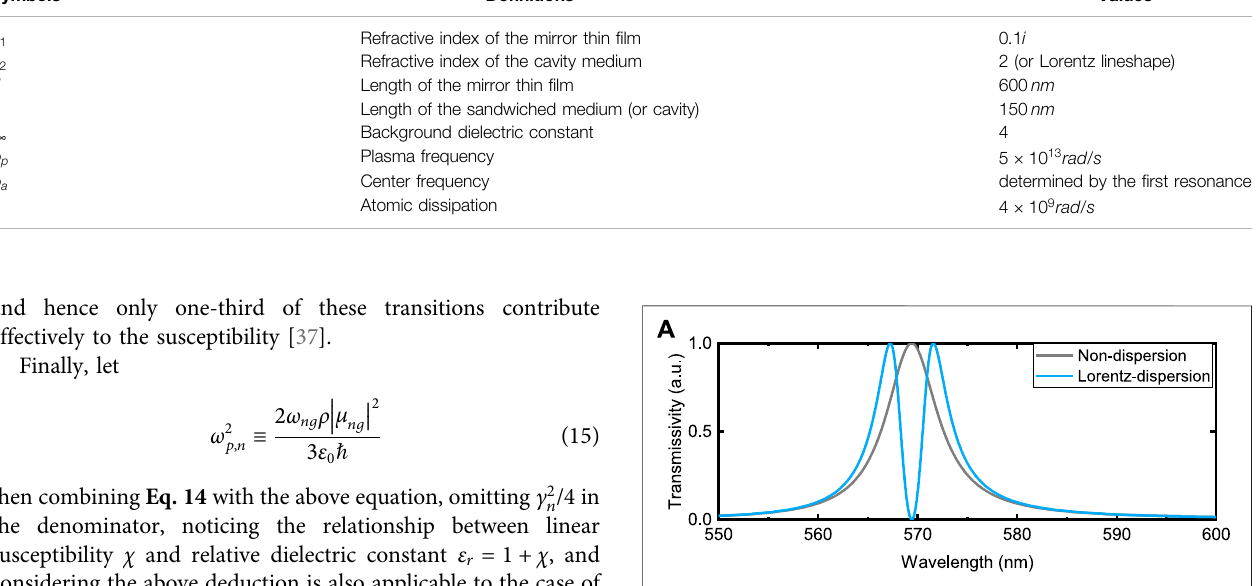
TABLE 1 | Cavity parameter for Figure 1A and Lorentz lineshape for Eq. 17 . Symbols